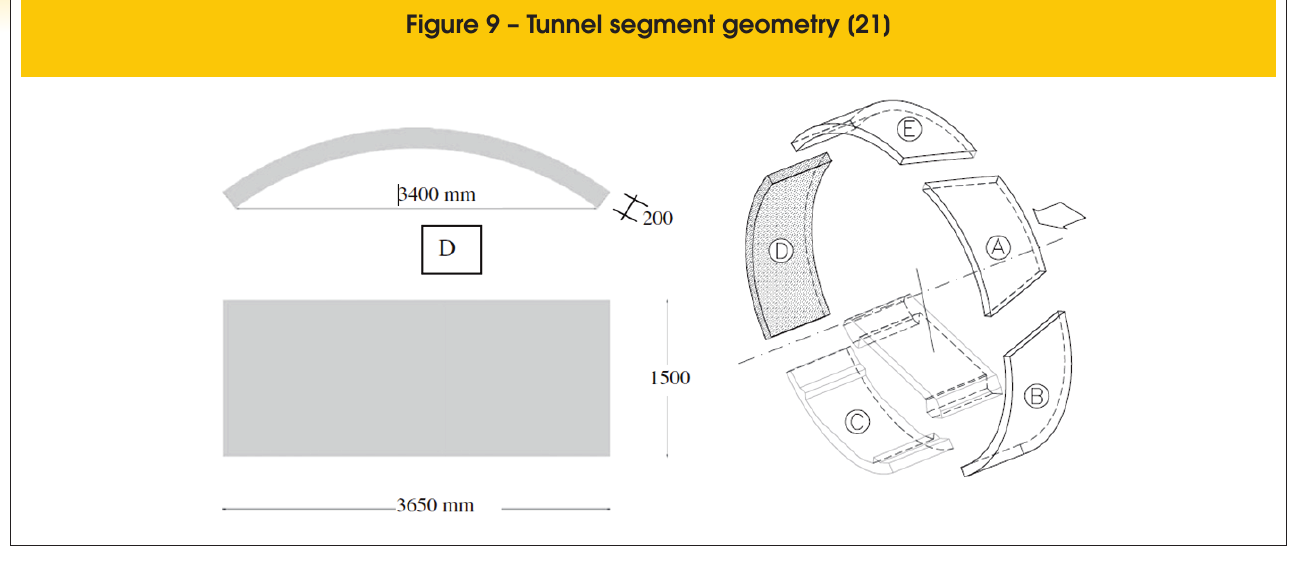
Figure 10 – Tunnel segment reinforcement